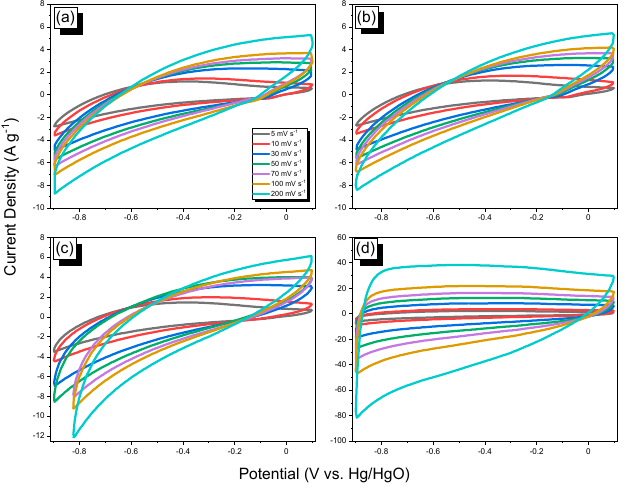
Figure 9. CV curves of ( a ) PA-BZ POP, ( b ) PA-BZ POP/metal composite, ( c ) MPC, and ( d ) PCMC. Figure 10a–d present the GCD curves of our samples, determined at various current densities. The GCD curves of all of the samples were triangular in shape, with only a slight bend, indicating both EDLC and pseudocapacitive characteristics [45,46]. After calcination at 500 °C, the discharging times of both the MPC and PCMC samples were longer than those of the PA-BZ POP and PA-BZ POP/metal composite (Figure 10a–d), indicating that calcination had an enhancement effect on the capacitance of our MPC and PCMC.